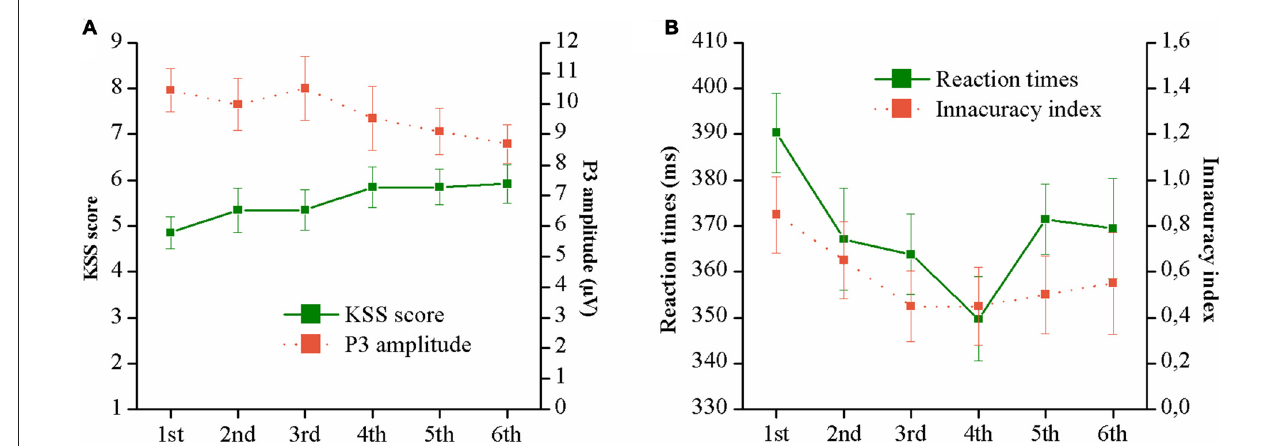
FIGURE 7 | P3 amplitudes, KSS scores (A) , reaction times and inaccuracy index (B) across the different conditions over time.